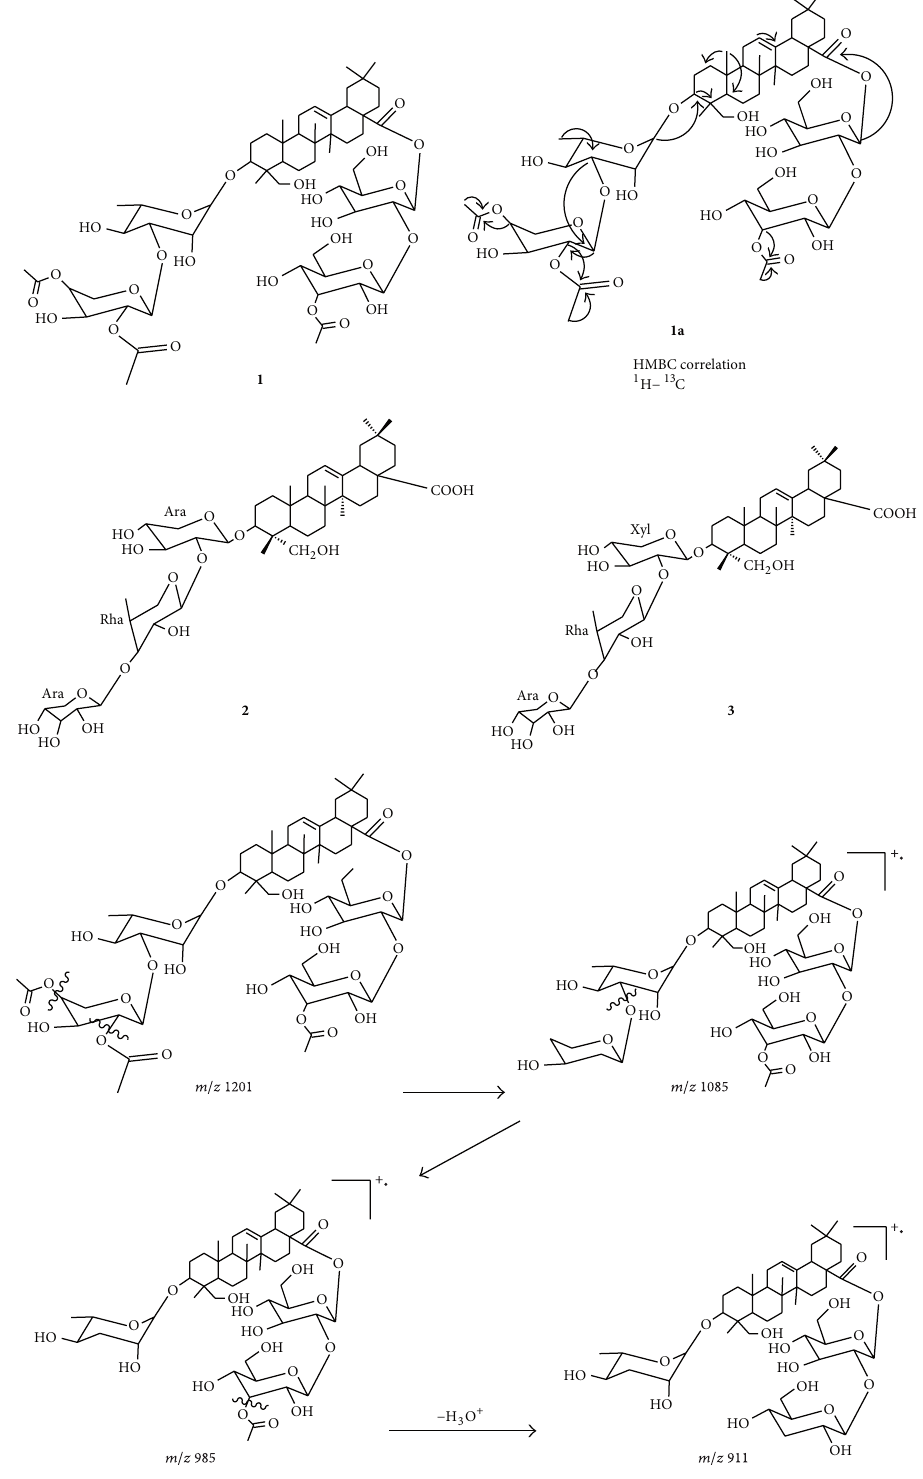
F 1: Mass fragmentation of compound 1